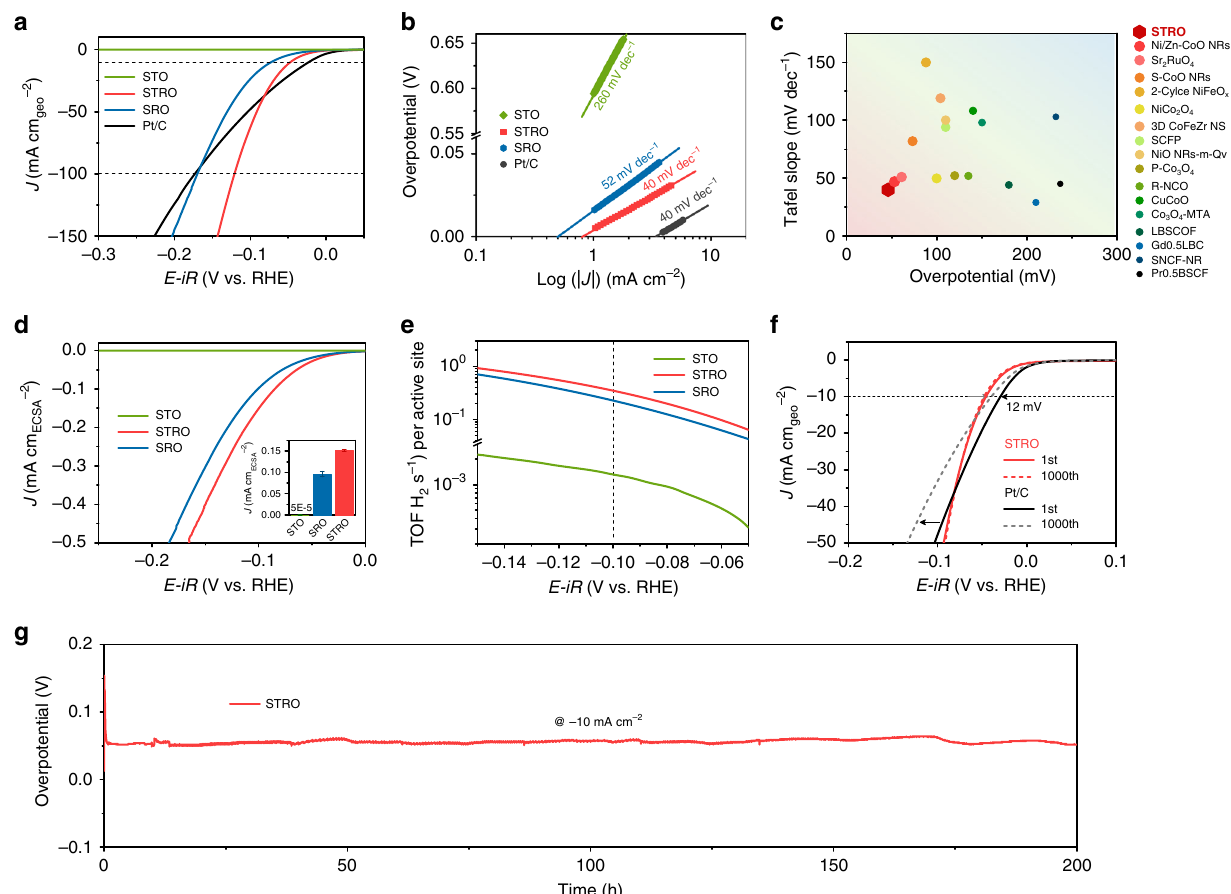
Fig. 3 Electrocatalytic HER performance in alkaline media. a Polarization curves of STO, STRO, SRO, and commercial Pt/C catalysts in an Ar-saturated 1 M KOH solution. Scan rate, 5 mV s − 1 . b The corresponding Tafel plots. c Alkaline HER activity comparison among metal oxides involving the overpotential@-10 mA cm -2 and Tafel slope. d Speci fi c activity normalized to ECSA of STO, STRO, and SRO catalysts as a function of applied potential. Inset: speci fi c activity at the overpotential of η = 0.1 V. e The relationship between TOF and the tested potentials for STO, STRO, and SRO catalysts in 1 M KOH solution. f Polarization curves of STRO and commercial Pt/C catalyst initially and after 1000 cycles during the accelerated durability tests. g Chronopotentiometry response of STRO at a constant cathodic current density of 10 mA cm − 2